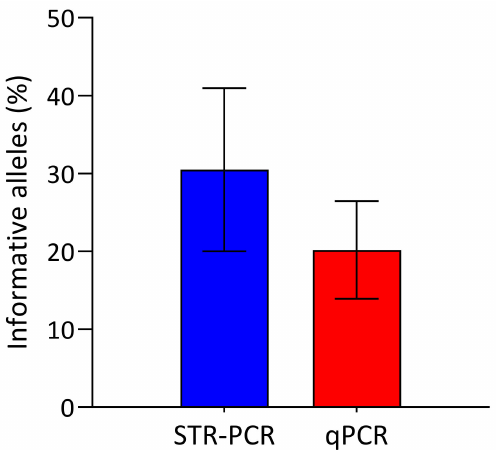
Figure 3. Informative loci. Percentage of informative loci for STR-PCR (blue) and qPCR